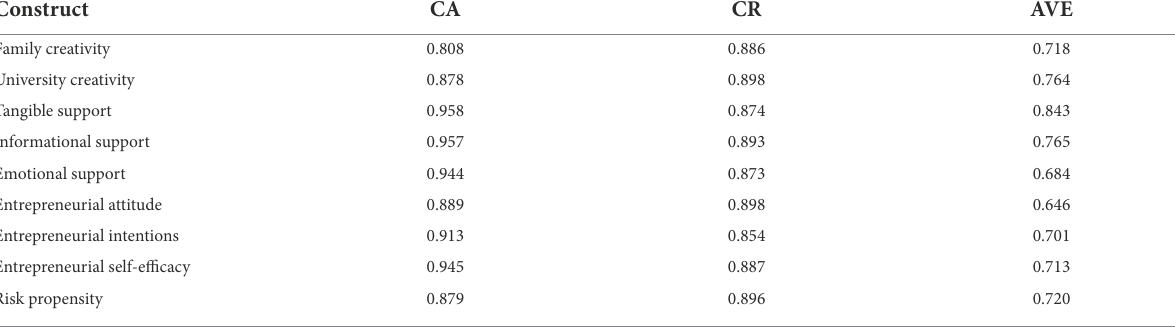
TABLE 3 The reliability and validity of the first-order reflective